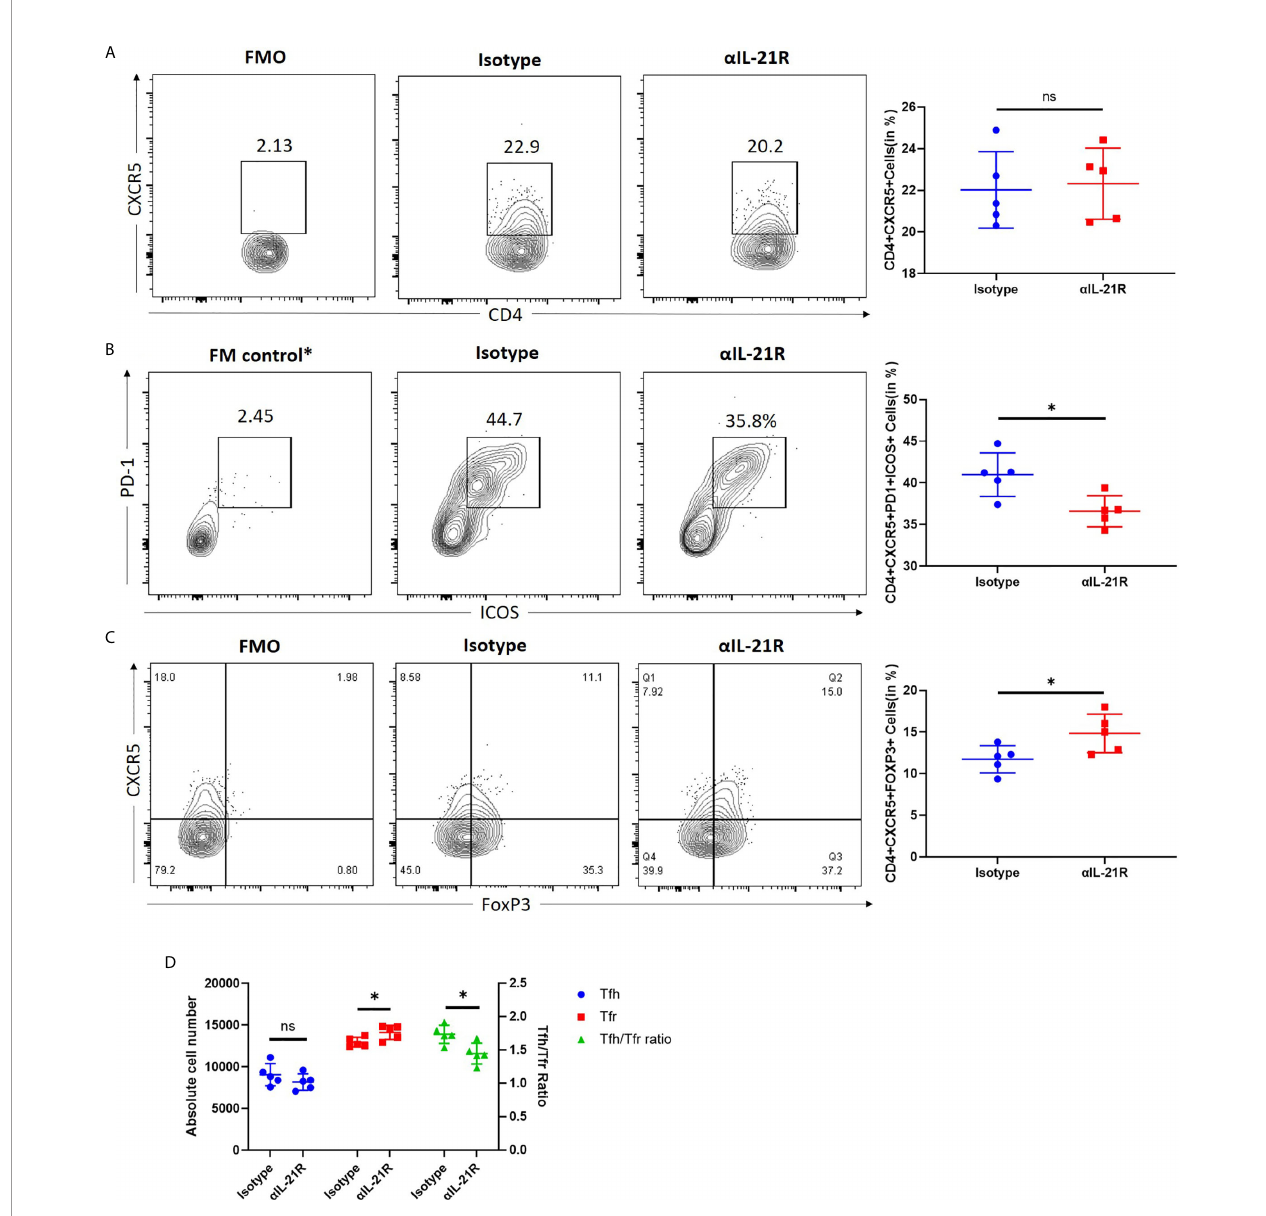
FIGURE 3 | a IL-21R decreases the Tfh/Tfr ratio in transplant recipient mice. Skin allografts from BALB/c mice were transplanted onto C57BL/6 mice. Recipients were treated with 1 mg/kg a IL-21R three times every week or Isotype starting on the day of transplantation. (A) Frequencies of CD4 + CXCR5 + T cells and (B) frequencies of CD4 + CXCR5 + ICOS + PD1 + Tfh cells and (C) frequencies of CD4 + CXCR5 + FOXP3 + Tfr cells in the spleen were assessed after 14 days by fl ow cytometry gating on single cells. (D) Absolute number of Tfh, Tfr cells and Tfh/Tfr ratio were calculated based on the results of fl ow cytometry by multiplication total number per sample and percentage of interested cells. Column plots display individual data points and mean ± SD, n = 5/group.